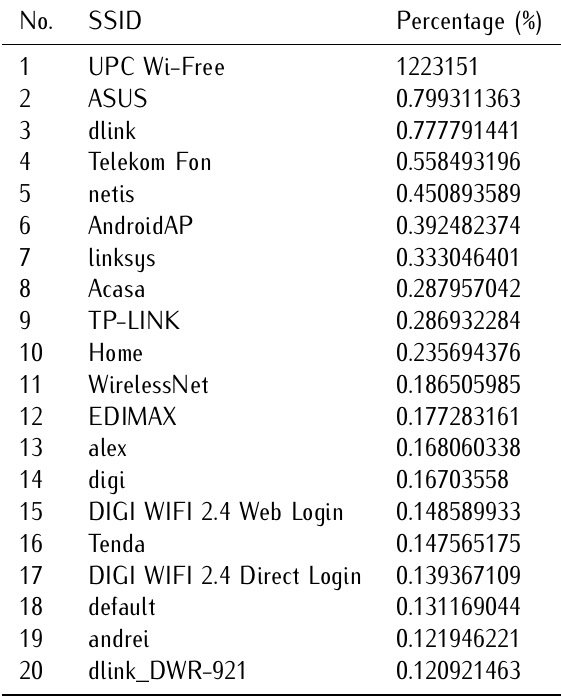
Table 4. WPS availability in Romanian wireless networks Table 5. Top 20 most common SSIDs in use in Romania